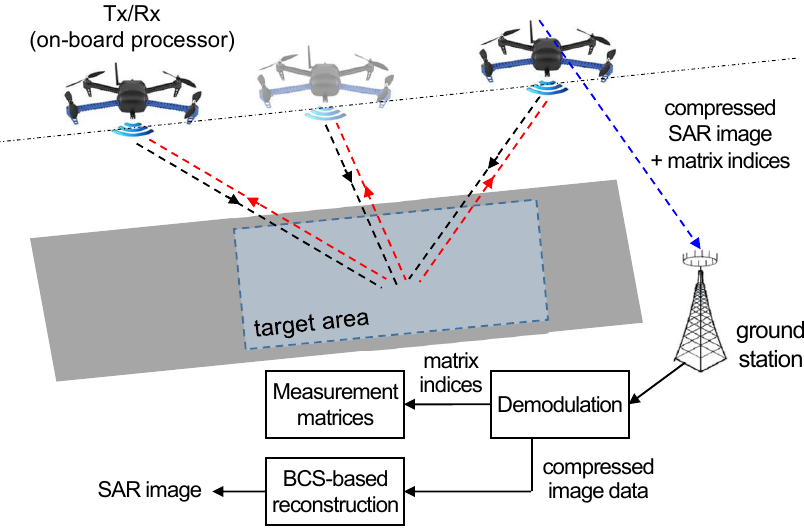
Figure 3. Drone SAR image processing using the proposed clustered